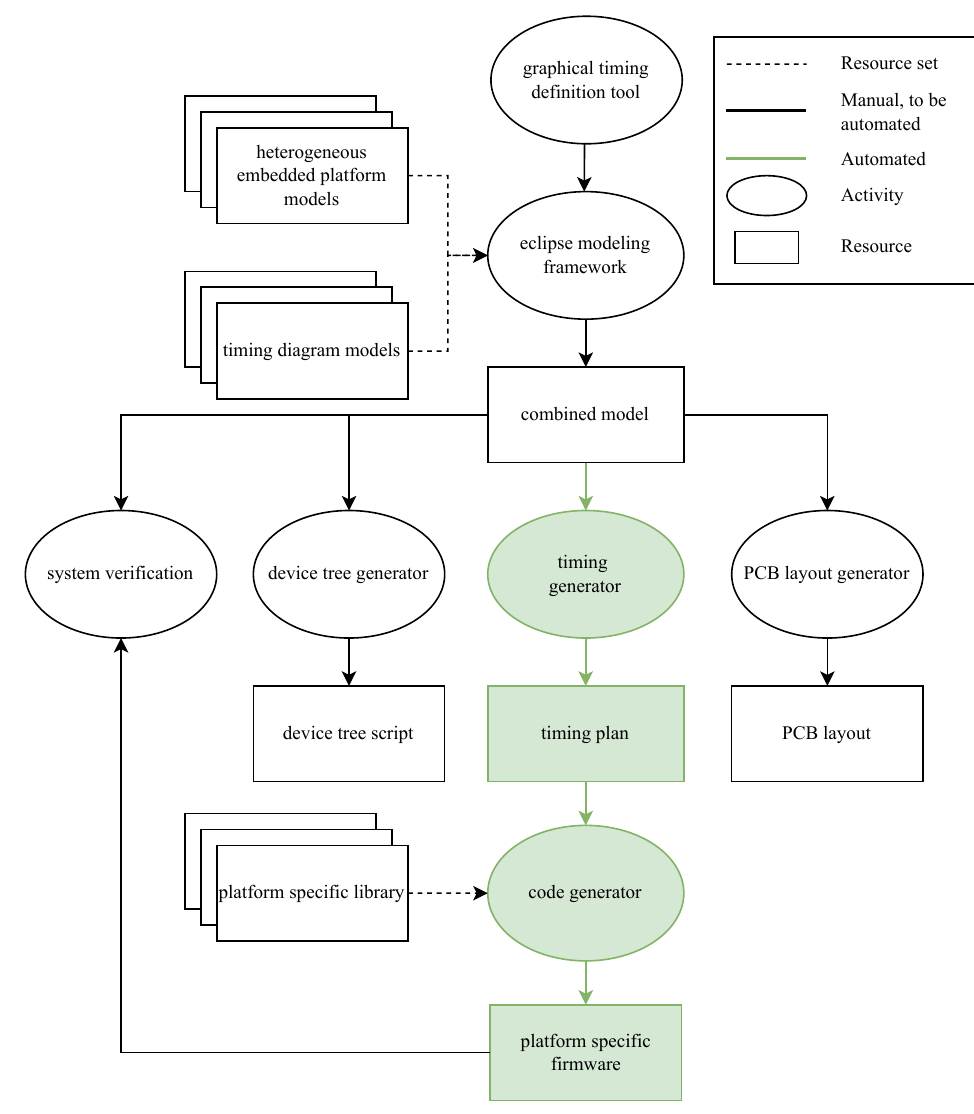
Figure 1. Overview of the proposed framework for model-based code generation for complex sampling schemes. The generation process starts by defining an acquisition sequence using a graphical timing definition tool. This is parsed into the eclipse modeling framework. From here, the acquisition sequence is automatically processed to generate a functional firmware in agreement with the specified acquisition sequence and heterogeneous platform